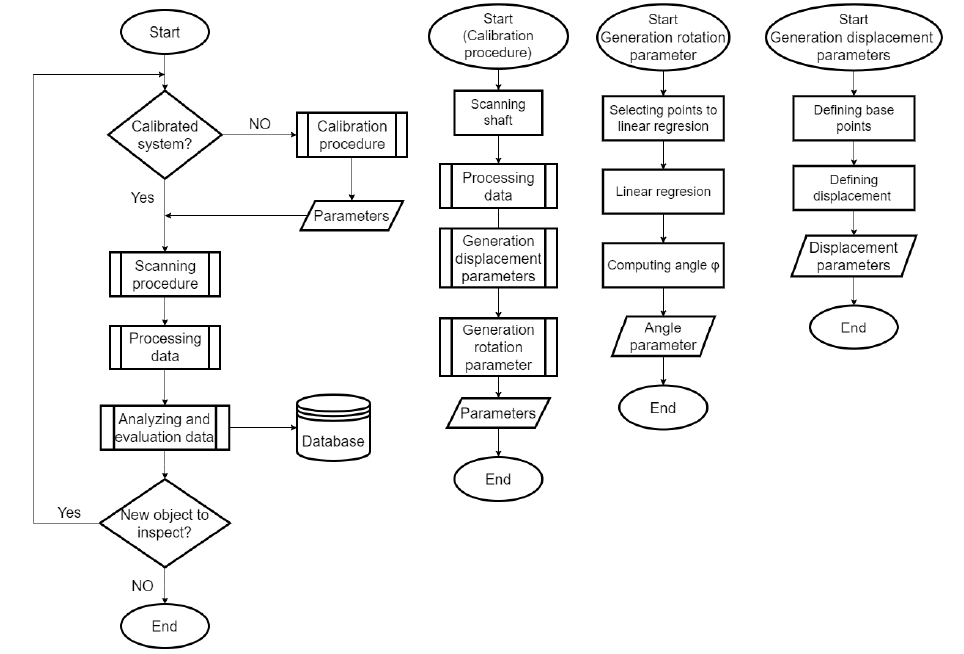
Figure 15. Algorithms of the inspection process.